Question: Author a descriptive caption for the visualization shown.
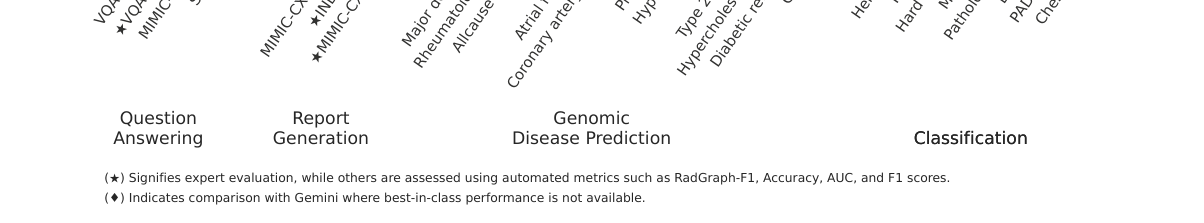
Answer: | Overview of our approach to curate and assess our family of medically tuned Gemini models, Med-Gemini. (top) These models build upon Gemini’s powerful capabilities in advanced reasoning, multimodal understanding, and long-context processing enriched with patient representation and medical knowledge. (bottom) Relative performance of Med-Gemini compared to SoTA or baselines across various tasks as detailed in Table A.15. Expert evaluation confirms that Med-Gemini-2D sets a new standard for AI-powered chest X-ray report generation, with relative improvements of 10% and 18% over the previous leading model across two distinct datasets. In histopathology, ophthalmology, and dermatology image classification, it surpasses baseline on 18 out of 20 tasks and approaches task-specific model performance. Med-Gemini-Polygenic outperforms the standard approach for disease risk prediction and generalizes to diseases for which it has never been trained.